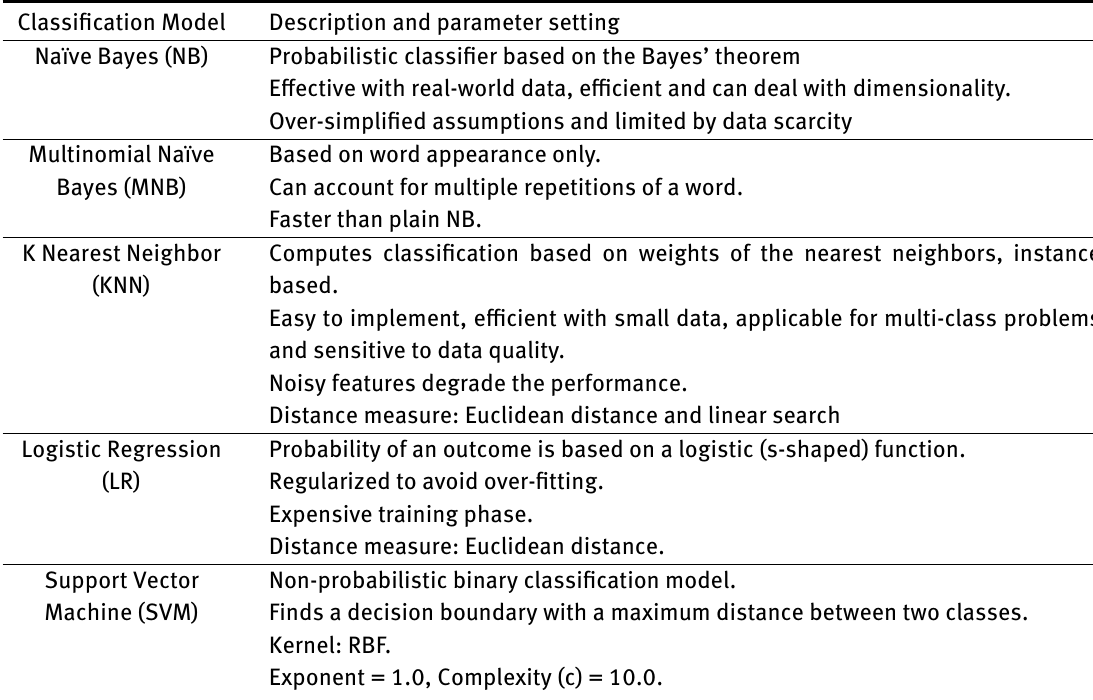
Table 6: Classification algorithms and setting